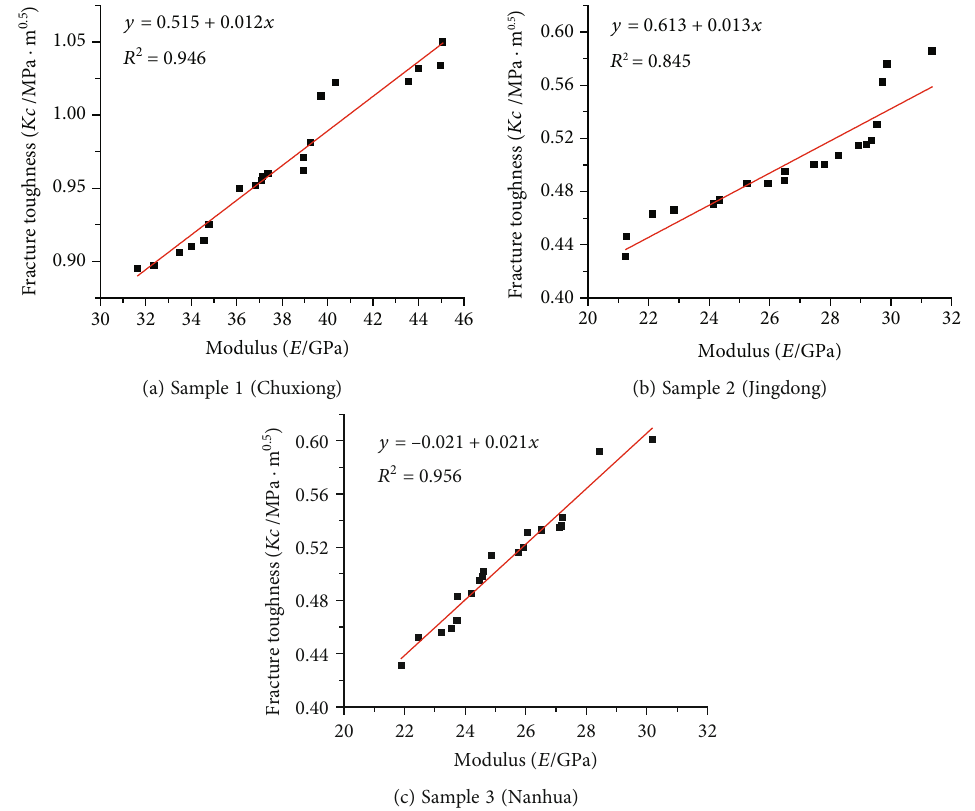
Figure 16: Fitting curve of mudstone fracture toughness and elastic